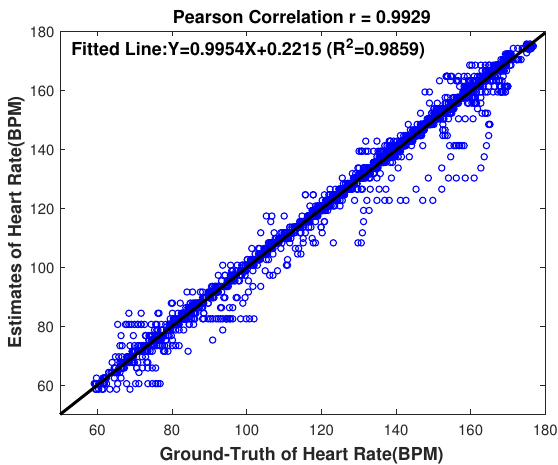
Figure 6. Scatter plot on the 22 datasets between the ground truth and the estimates of our proposed approach. The fitted line was y = 0.9954 x − 0.2215; the R 2 value was 0.9859; the Pearson correlation correlation was